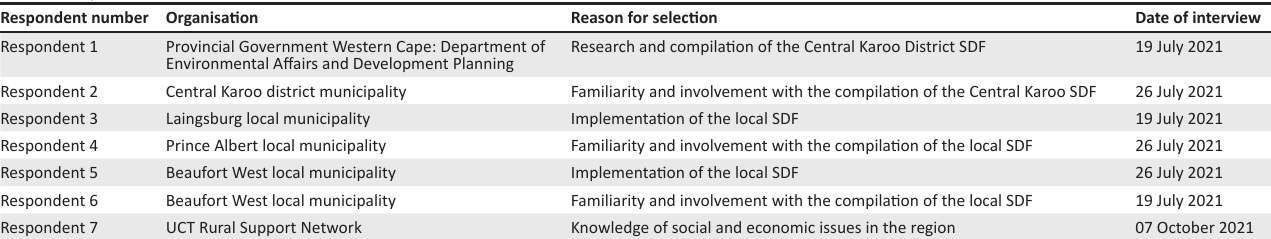
TABLE 1: Key informants